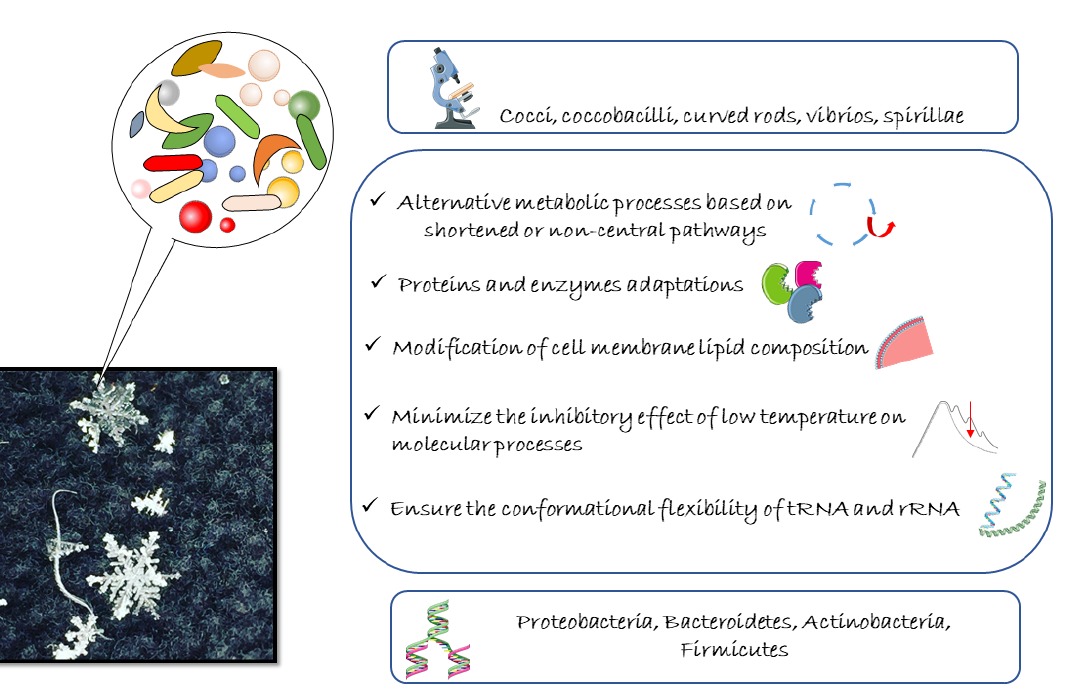
Figure 1. Main features of cold-adapted bacteria associated with frozen matrices and main survival strategies to front cryoinjuries.